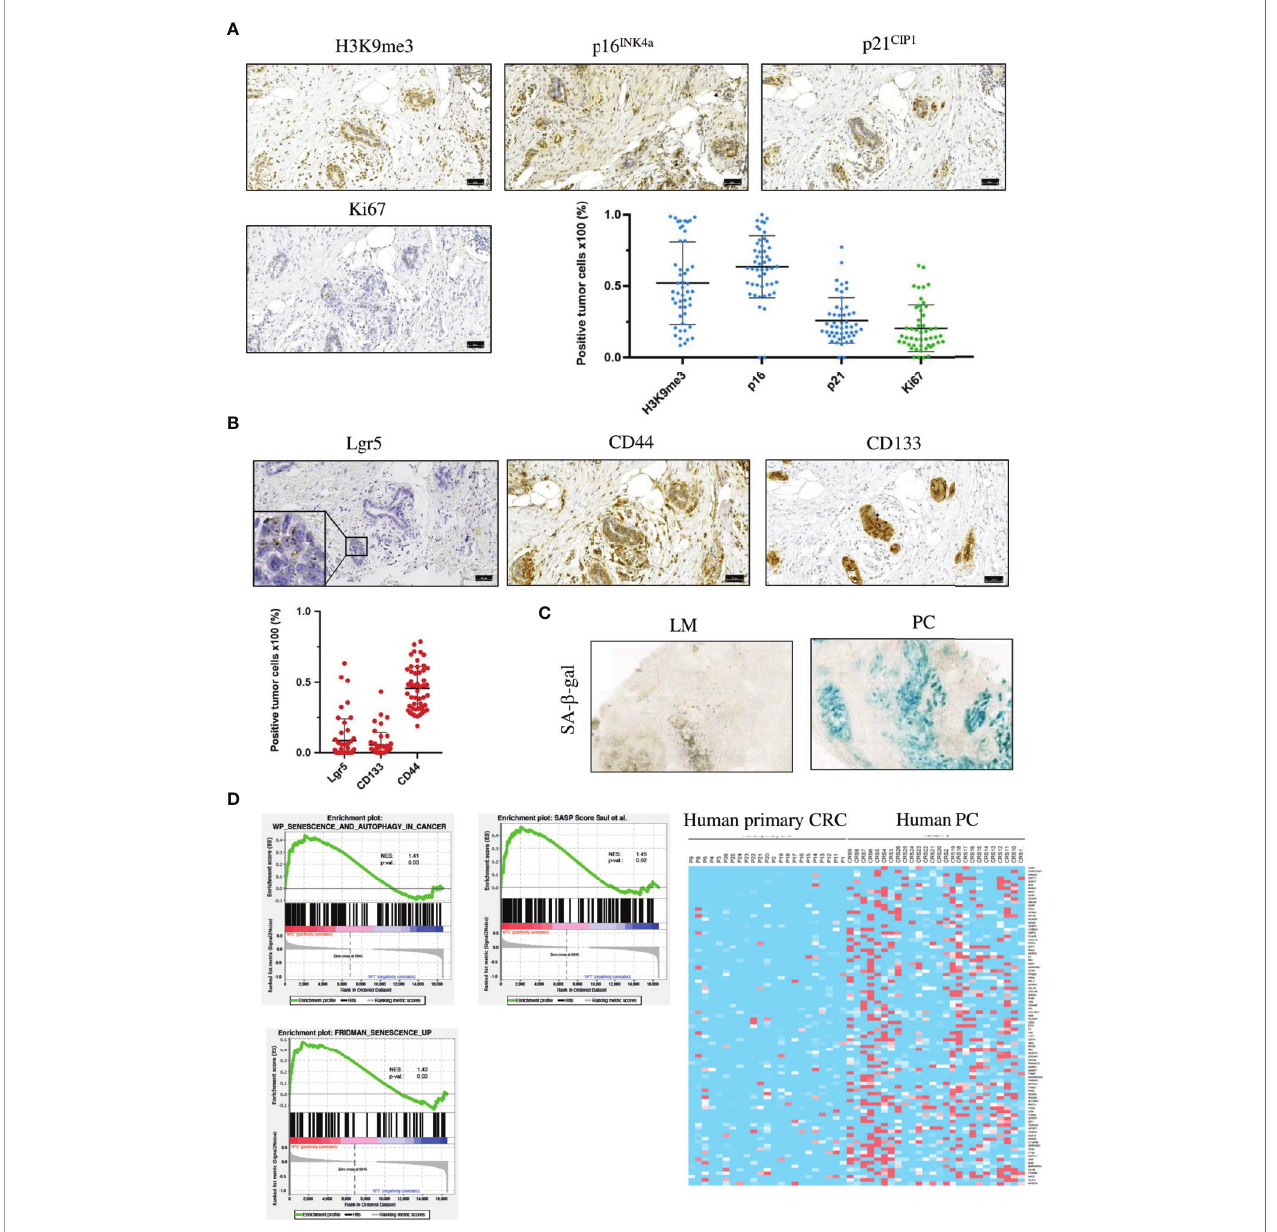
FIGURE 1 | Human PC cancer cells are senescent, have a SASP and show signs of a stem cell-like phenotype. (A) Representative images of IHC staining for the senescence-associated markers H3K9me3, p16 INK4a and p21 CIP1 and the proliferation marker Ki67 and quanti fi cation of the different markers from one patient. Scale bar: 50 µm, error bars represent the mean ± SD. (B) Representative images of IHC staining for the stem cell markers CD44 and CD133 and RNA in situ hybridization for Lgr5 from the same patient as in (A) Inset represents 125x magni fi cation. Scale bars: 50 µm, error bars represent the mean ± SD. (C) Representative images of SA- b -gal in a liver metastasis (left) and PC (right), n = 3 per group. (D) Gene set enrichment analysis pro fi les of senescence and autophagy genes, SASP genes and senescence-associated genes from primary tumors (n = 23) and PC samples (n = 26) from the TCGA PanCancer collection. Heat map of SASP genes from the same patient collective as in the gene set enrichment